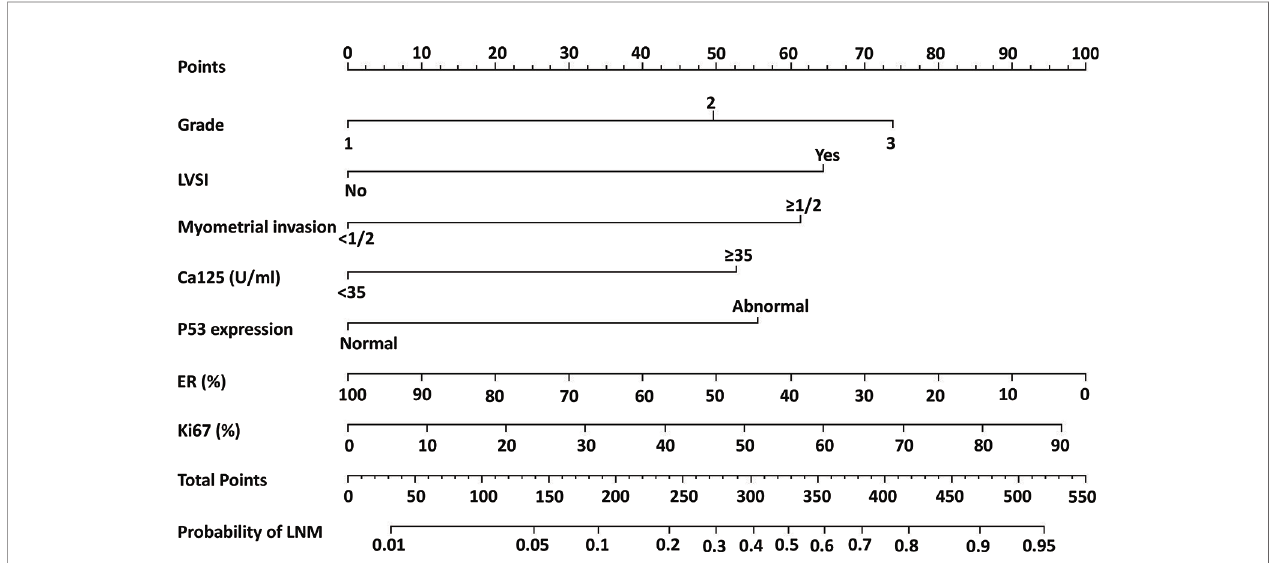
FIGURE 2 | Nomogram model for estimating the probability of LNM in women with endometrial cancer. To estimate the probability of LNM, locate the patient ’ s grade on the “ grade ” axis. Draw a straight line up to the “ point ” axis to determine the points for grade. Repeat the process for each of the remaining axes, drawing a straight line each time to the “ point ” axis. Add the points received from each variable and locate this number on the “ total point ” axis. A straight line is drawn down from the “ total point ” axis to the “ probability of LNM ” axis to determine the risk of LNM in